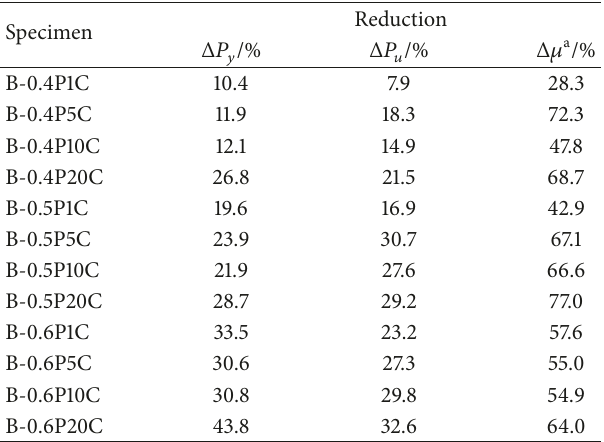
Table 4: Reduction of yield load, ultimate load, and ductility of